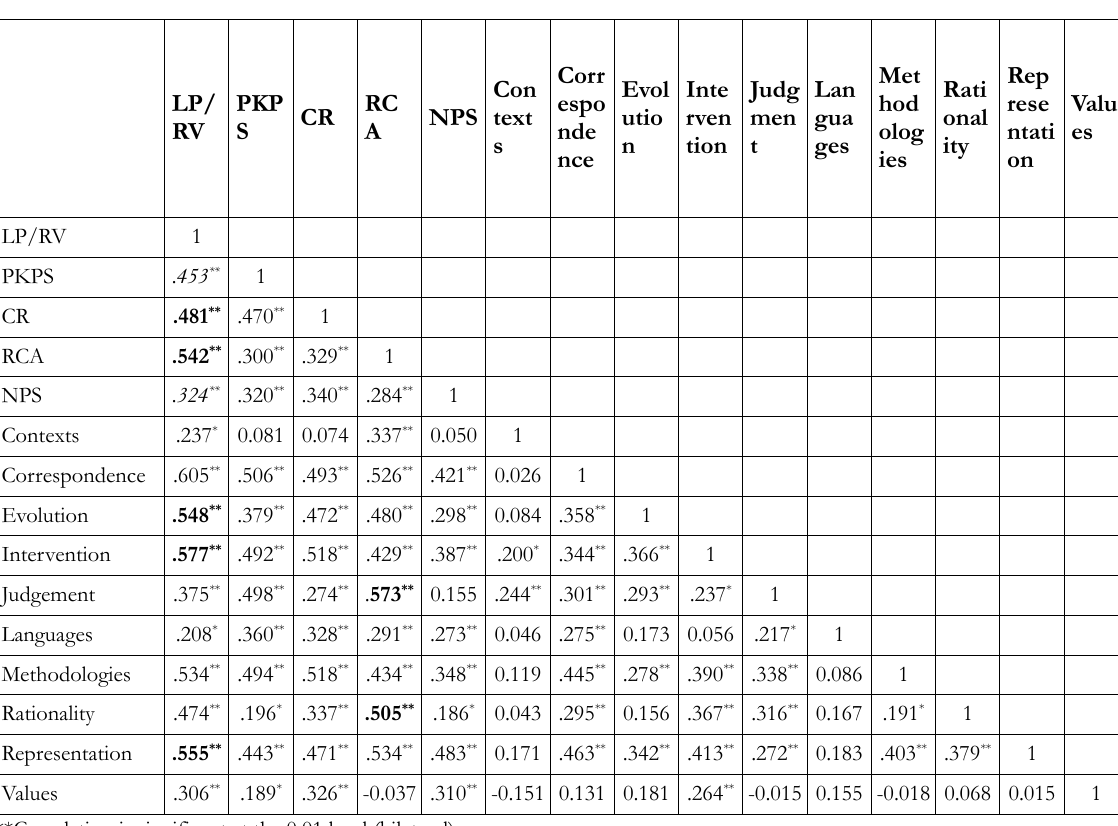
Table 3. Ranges of interpretation for the correlation coefficient